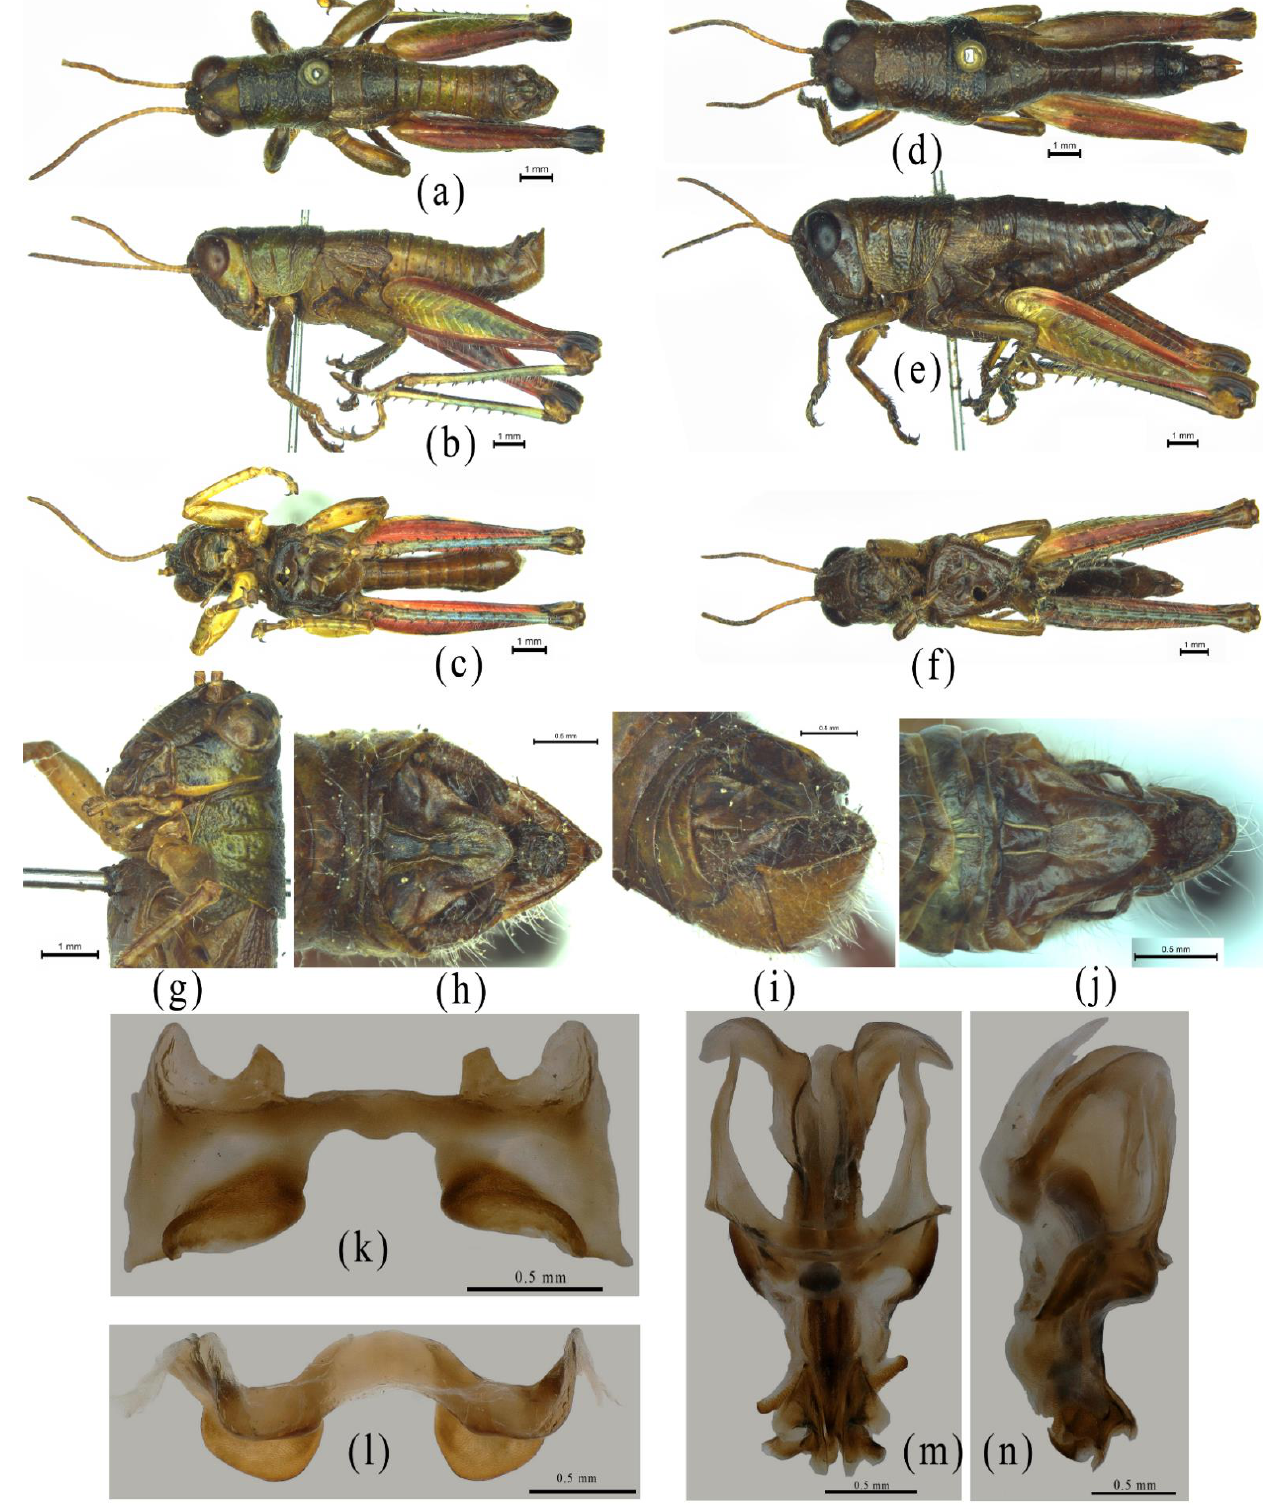
Figure 6. Morphological characters of Yunnanacris yunnaneus . ( a – c ) Male habitus. ( d – f ) Female habitus. ( g ) Head and pronotum of a male showing the shape of the prosternal process. ( h ) Terminal abdomen of a male in dorsal view showing the furculum. ( i ) Terminal abdomen of aale in lateral view, showing the shape of the cercus. ( j ) Terminal abdomen of a female in dorsal view. ( k , l ) Epiphallus in dorsal and anterodorsal view. ( m , n ) Phallic complex in dorsal and lateral view.